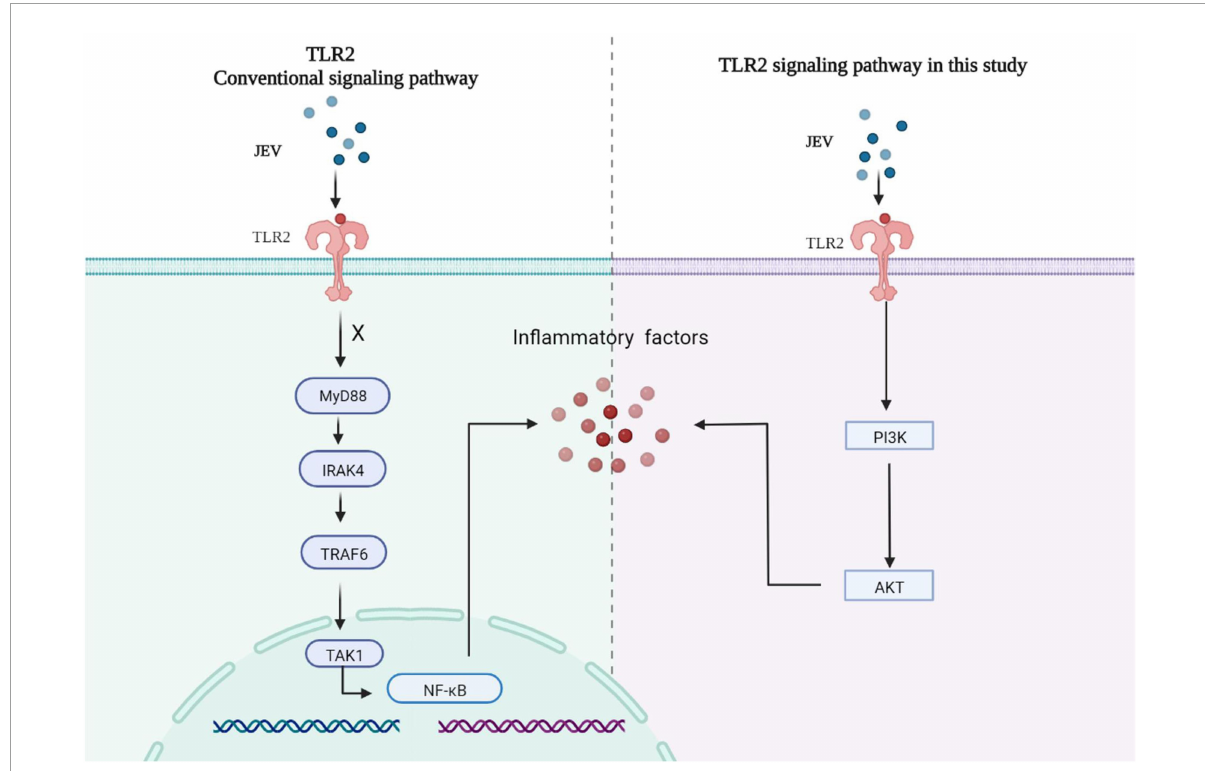
FIGURE6 JEV infection increased the expression of key factors of the inflammatory response via the TLR2-PI3K-AKT signaling axis. The MyD88 signaling pathway downstream of TLR2 was not activated, and the NF- κ B signaling pathway was not regulated by